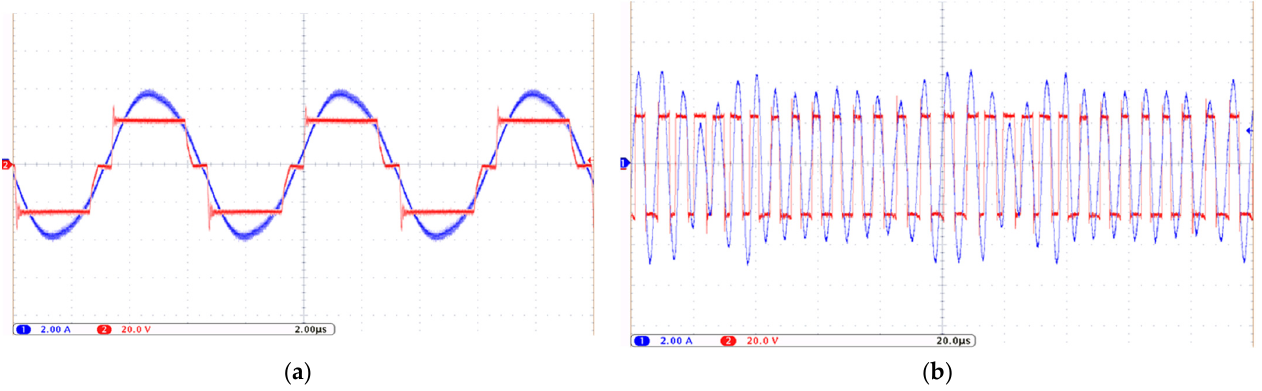
Figure 9. The waveforms of H-bridge inverter output voltage (red) and current (blue): ( a ) for the wireless charger without the spread spectrum ( f 1 = 153 kHz, load resistance 12.6 Ω ); ( b ) for the wireless charger with the three-switching-frequency technique ( f 1 = 173 kHz, f 2 = 153 kHz, f 3 = 133 kHz; N 1 = 6, N 2 = 4, N 3 = 5; load resistance 12.6 Ω ). Scale: 2 A/div.; 20 V/div.